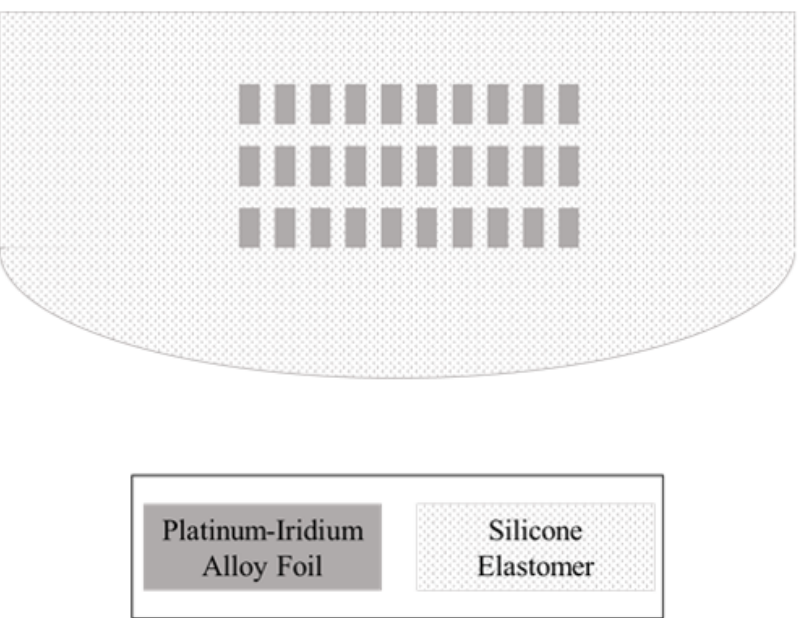
Figure 8. Structure of the triple-layer wire bundle. Thirty wires are placed in 3 layers, each with 10